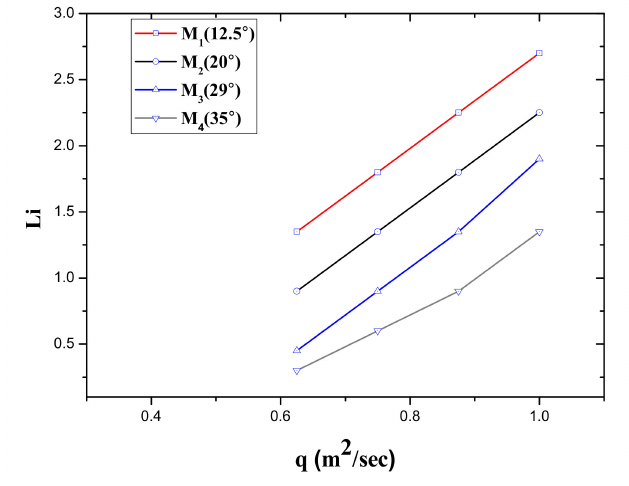
Figure 7. Relationship between discharge (q) and inception point length of different sloped stepped